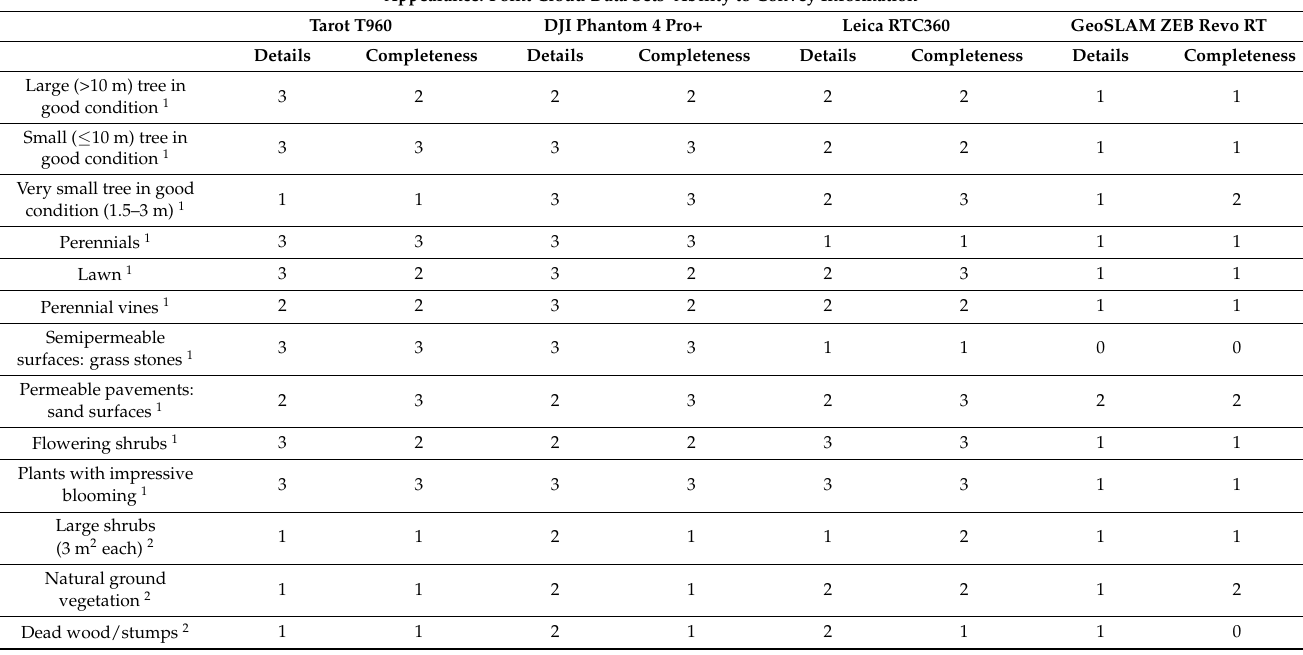
Table 4. The point cloud data sets’ ability to convey information on the green elements’ appearance, with 3 denoting good ability, 2 denoting moderate ability, 1 denoting low ability, and 0 denoting no ability to convey information on the given